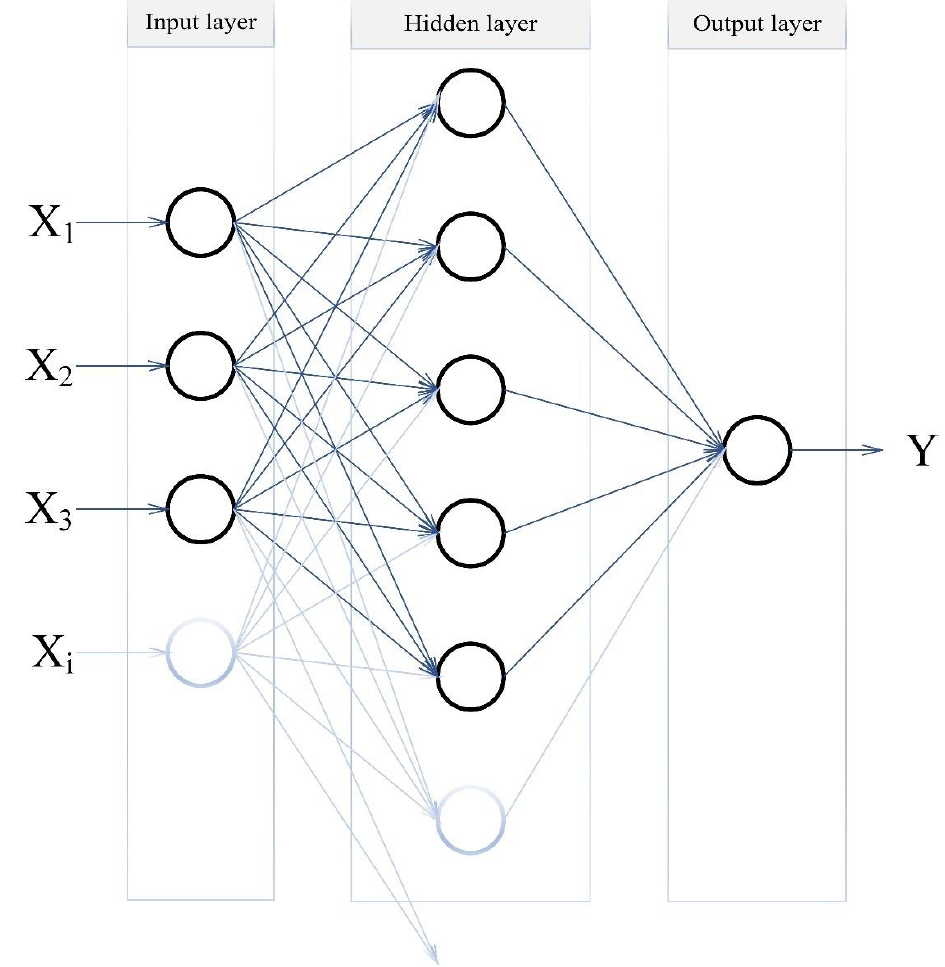
Figure 3. Generalized form of the artificial neural network model-multilayer perceptron.